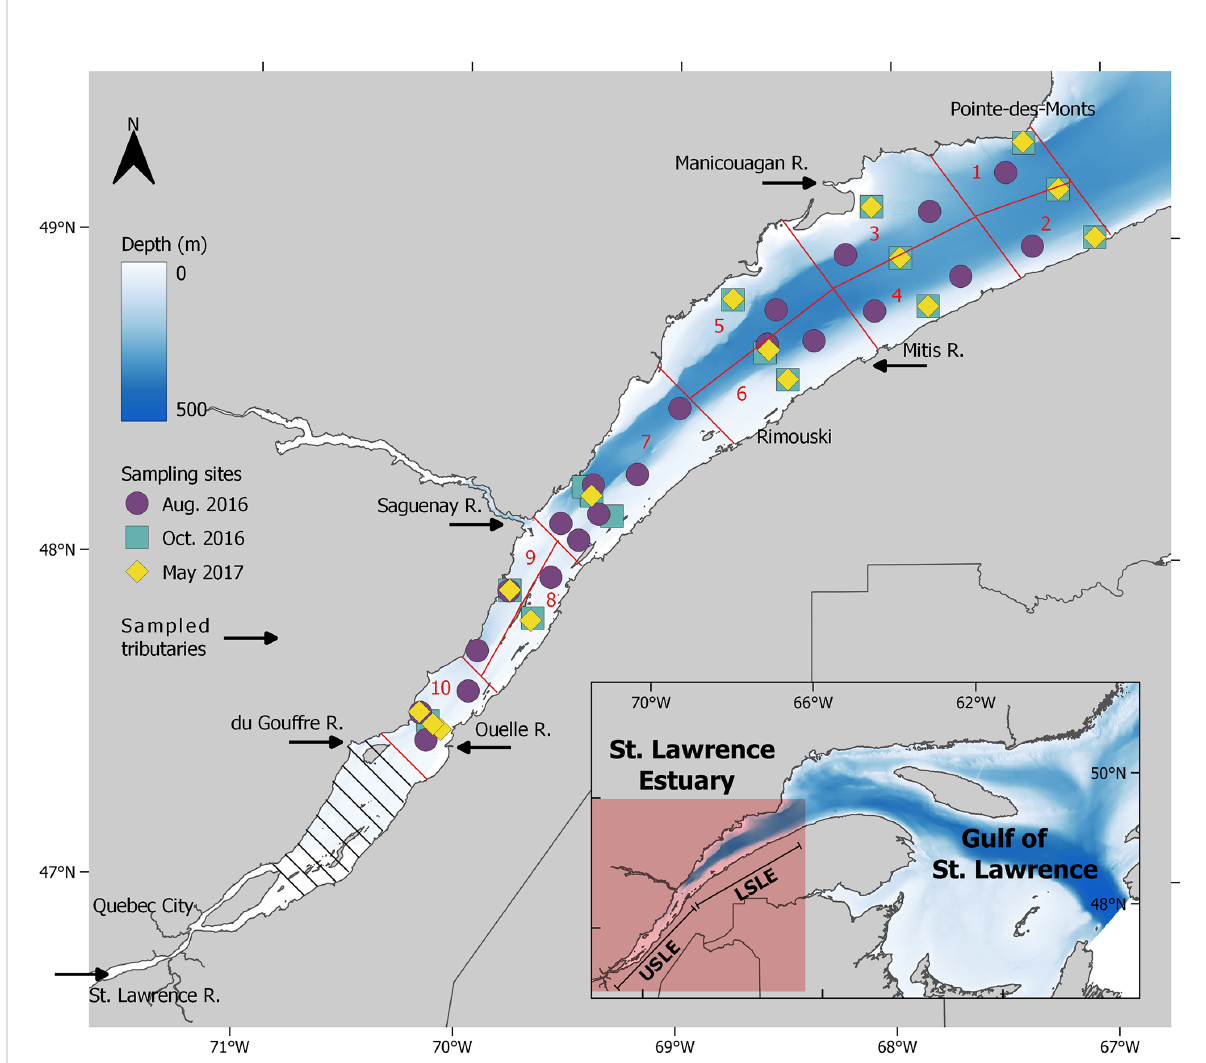
FIGURE 1 Six sampled tributaries and sampling sites for the August 2016, October 2016 and May 2017 time periods in the lower (sectors 1 – 7) and upper St. Lawrence Estuary (sectors 8 – 10) downstream of the maximum turbidity zone (hatched area).